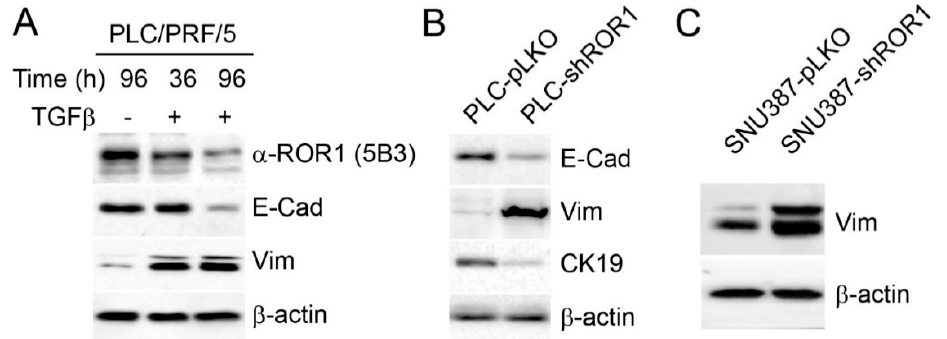
Figure 4. Knockdown of ROR1 is associated with the mesenchymal phenotype. ( A ) PLC/PRF/5 cells were treated with 4 ng/mL TGF- β for 36 and 96 h. Western blotting shows the expression of ROR1, E-cadherin and vimentin. ( B ) Analysis of the expression of mesenchymal phenotype related proteins in PLC-shRNA ROR1-knockdown and control clones. ( C ) Expression of vimentin in 387-shRNA ROR1-knockdown and control clones. β -actin was used as a loading control.